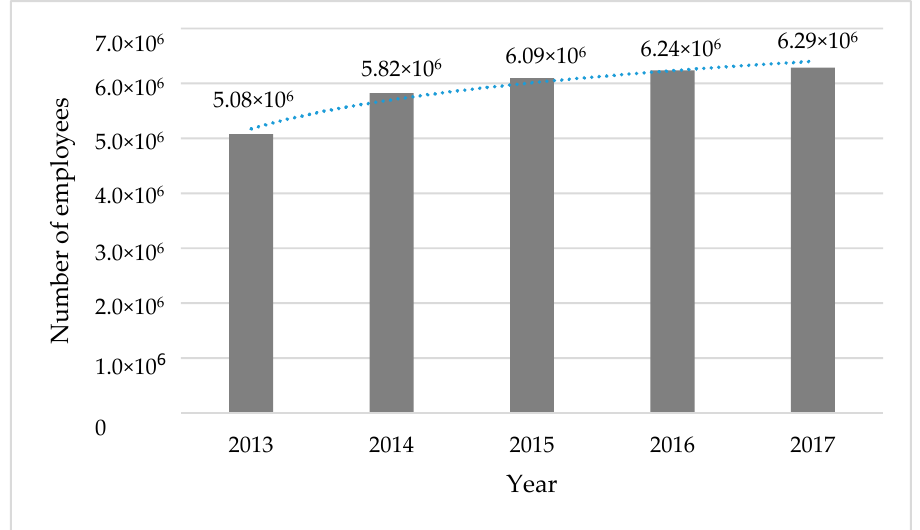
Figure 7. Number of employees in Romania in 2013–2017 [2].